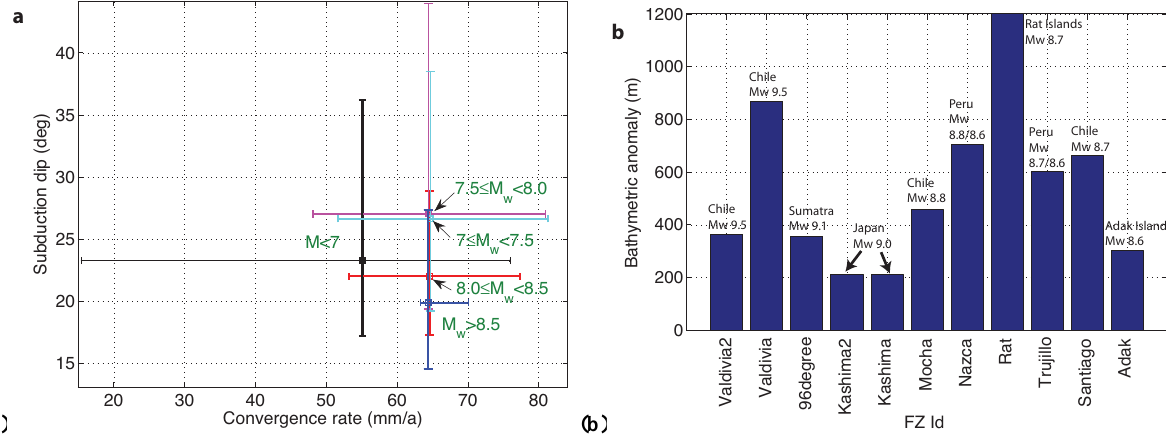
Fig. 3. (a) Filtered earthquakes grouped in five magnitude categories plotted as a function of median slope of the subduction coupling zone (Hayes et al., 2012) versus the median (trench perpendicular) geodetic convergence rates (Kreemer et al., 2003), with error-bars depicting 20th/80th percentiles. (b) Elevation of fracture zone ridges relative to the adjacent ocean floor for the 13 largest earthquakes on record associated with FZ–SZ intersections amongst the top 15 events (see Figs. 1 and 2). Bathymetry profiles ∼ 300km in length were extracted ∼ 100km seaward of the trench, perpendicular to fracture zones. Fracture zone ridge heights were computed by measuring the total height between ridge crests and fracture zone